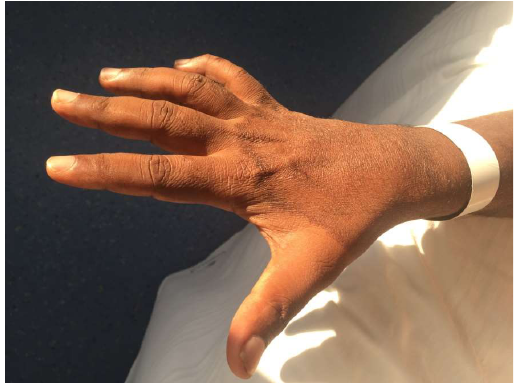
Figure 2. Skin lesion over the dorsum of hand in a 38-years old migrant from Sri Lanka with a diagnosis of borderline tuberculoid leprosy.